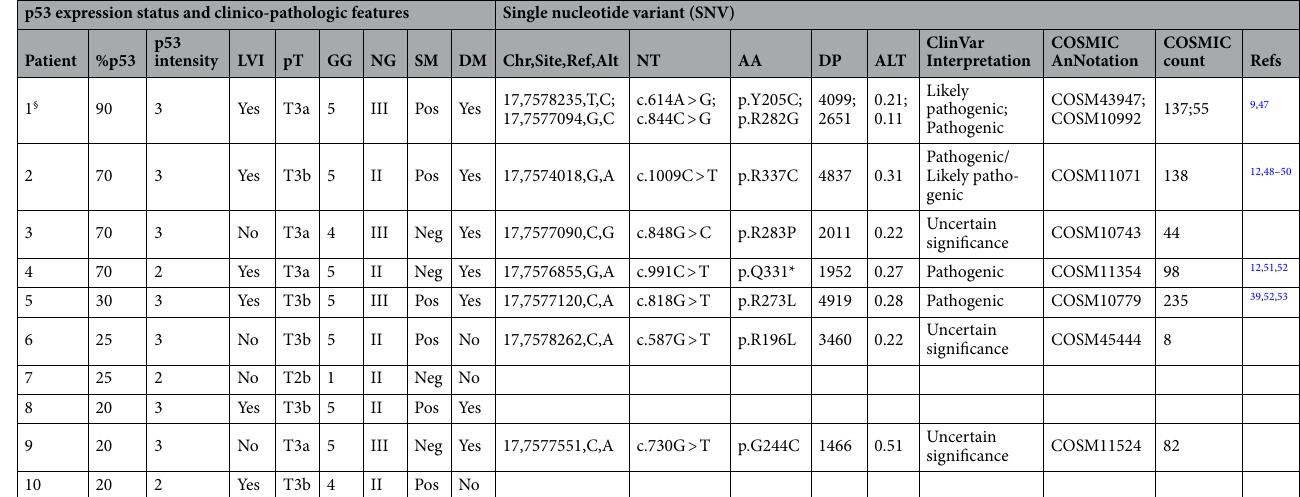
Table 4. Clinico-pathologic features and TP53 mutations for a subset of ten patients with p53(+) ≥ 20%. LVI = Lymphovascular Invasion; pT = Pathologic Stage; GG = Grade Group; NG = Nuclear Grade; SM = Surgical Margin; DM = Distant Metastasis; NT = Nucleotide change; AA = Amino Acid change; DP = Depth of Coverage; ALT = Frequency of alternate allele; Pos = positive; Neg = Negative. § Two distinct TP53 mutations were detected in patient 1 who exhibited 90% p53 protein